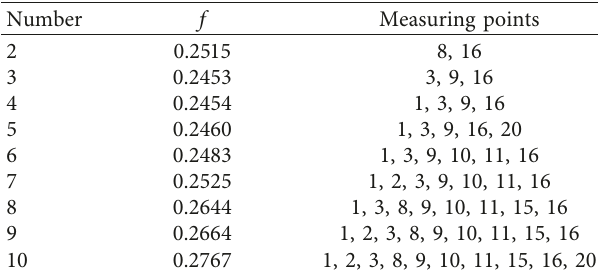
Figure 6: Description of the optimum placement scheme: (a) the primary measuring points; (b) the minimum MAC ij . Table 2: Measuring points placement based on the